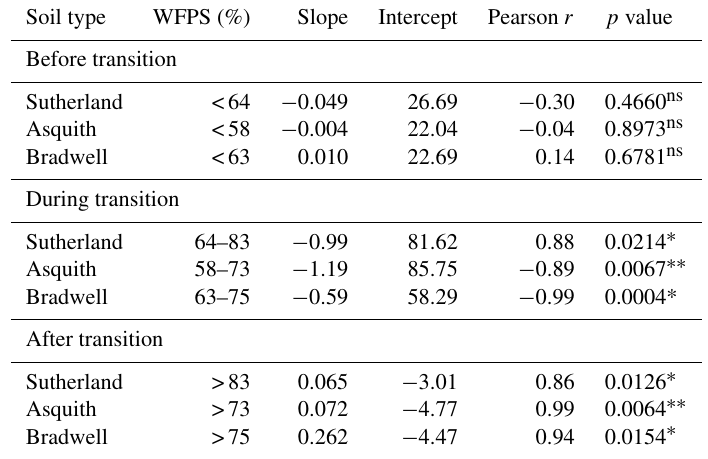
Soil type WFPS (%) Slope Intercept Pearson